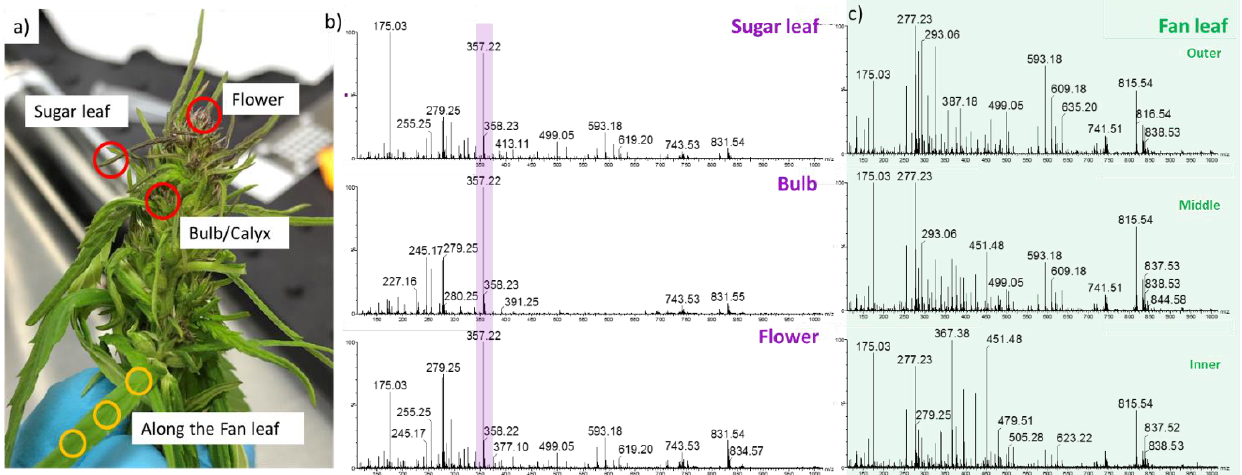
Figure 2. In vivo SpiderMass analysis on cannabis plants. ( a ) Photo of a cannabis plant with indicated plant organs and measurement points (red and yellow circles). ( b ) Examples of negative ion mode mass spectra from the sugar leaf, bulb, and flower. The highlighted area shows the m/z 357.2 ion that corresponds to the mixed signal of THCA/CBDA. ( c ) Examples of negative ion mode spectra recorded along the fan leaf (outer, middle, and inner).